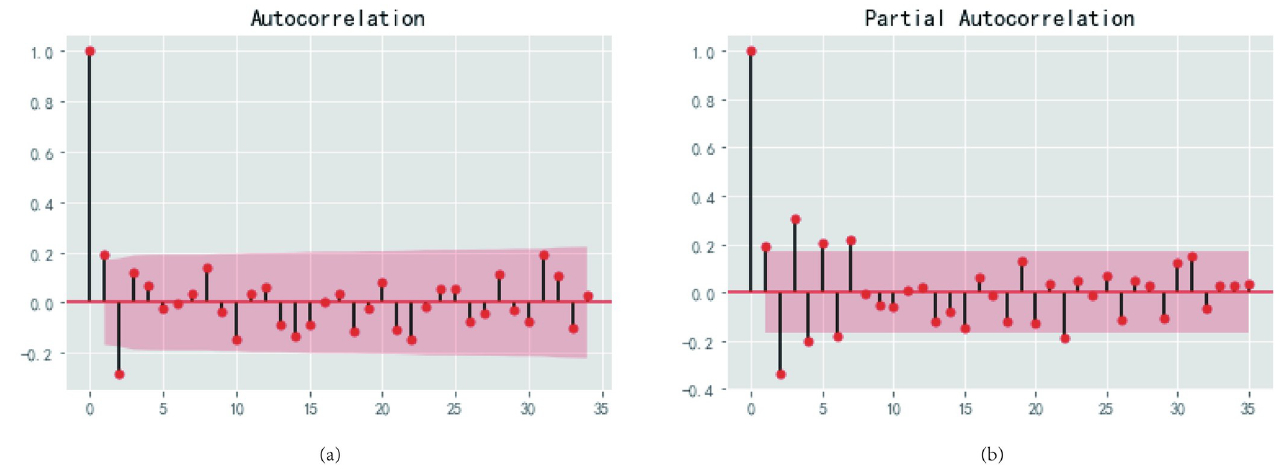
Fig 16. Residuals autocorrelation (a) and partial autocorrelation (b).